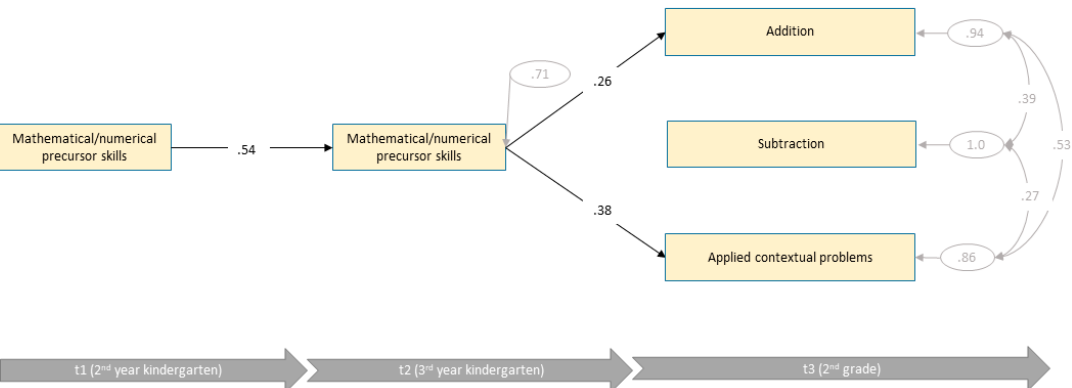
Figure 5. Final path model of high intellectual ability group with standardized path coefficients ( n = 135).